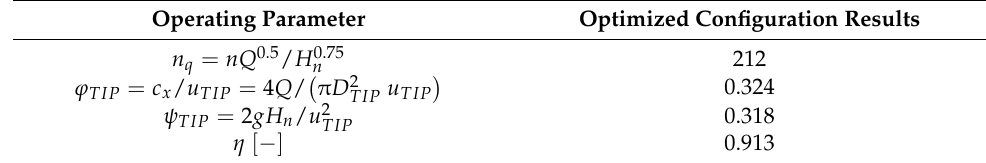
Table 1. Propeller turbine design operating parameters.